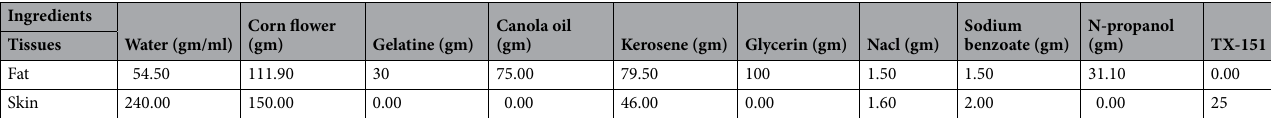
Table 5. Ingredients for 500 gm fat and skin fabrication.